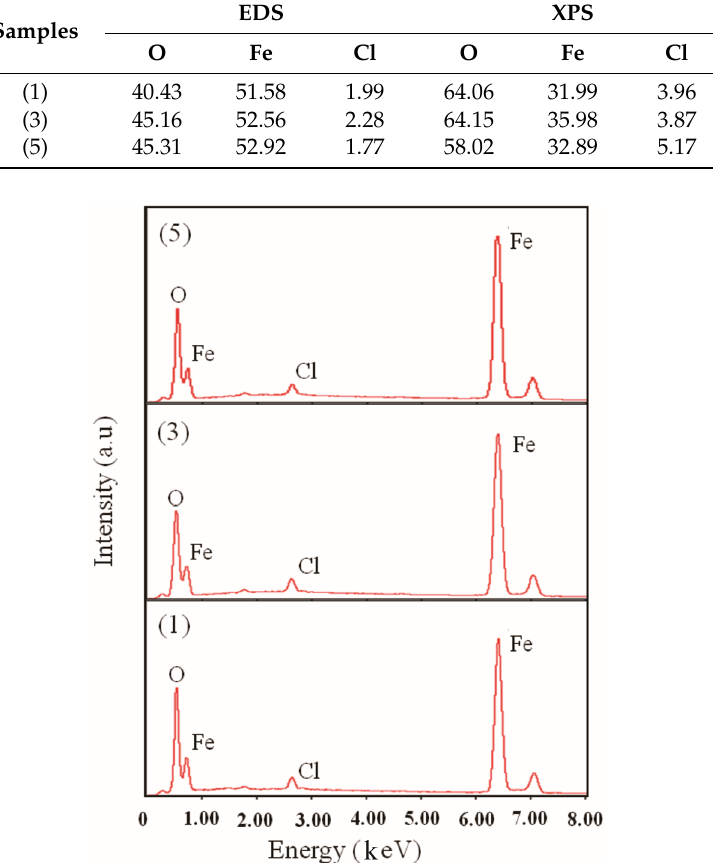
Figure 4. EDS spectra of samples (1), (3), and (5).